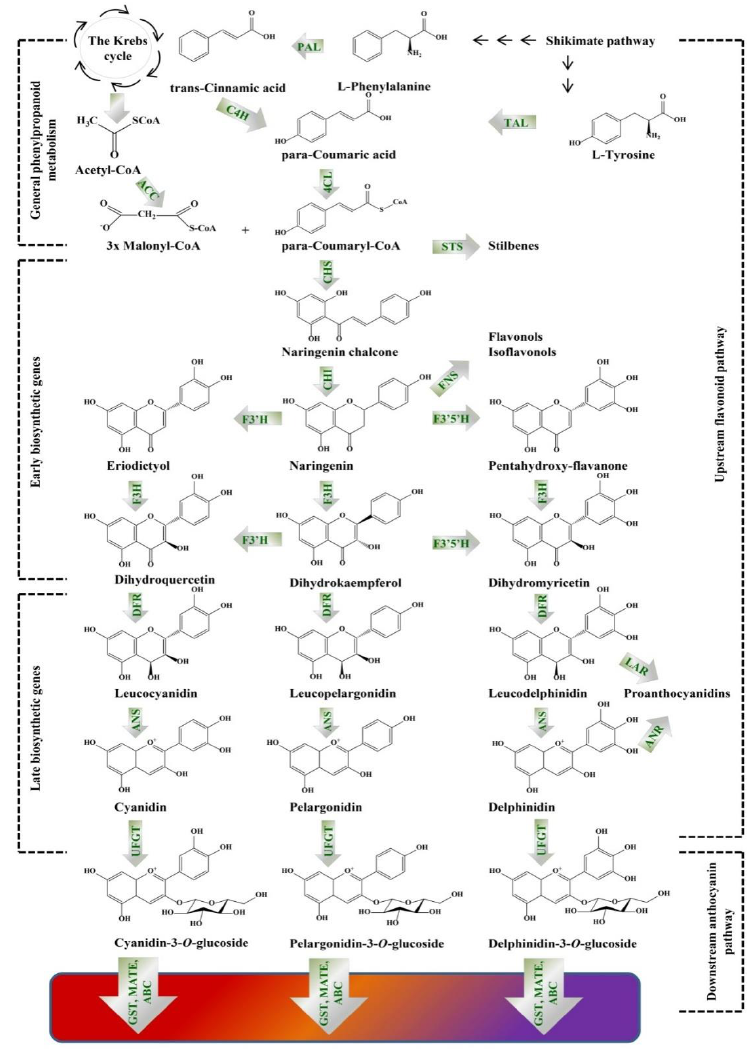
Figure 1. Illustration, presenting the biosynthetic pathway of colored anthocyanins. PAL, phenylalanine ammonia lyase (EC 4.3.1.24); TAL, tyrosine ammonia lyase (EC 4.3.1.23); C4H, cinnamate 4-hydroxylase (EC 1.14.14.91); ACC, acetyl-CoA carboxylase (EC 6.4.1.2); 4CL, 4- coumarate-CoA ligase (EC 6.2.1.12); CHS, chalcone synthase (EC 2.3.1.74); STS, stilbene synthase (EC 2.3.1.95); CHI, chalcone isomerase (EC 5.5.1.6); F3′H, flavonoid 3’-hydroxylase (EC 1.14.13.21); F3′5′H, flavonoid 3´5´-hydroxylase (EC 1.14.13.88); FNS, flavones synthase (EC 1.14.11.22); F3H, flavanone 3- hydroxylase (EC 1.14.11.9); DFR, dihydroflavonol 4-reductase (EC 1.1.1.219); ANS, anthocyanidin synthase (EC 1.14.20.4); LAR, leucoanthocyanidin reductase (EC 1.17.1.3); ANR, anthocyanidin reductase (EC 1.3.1.112); UFGT, UDP-glucose:flavonoid-3- O -glycosyltransferase (EC 2.4.1.115); GST, glutathione S -transferase (EC EC 2.5.1.18); MATE, multidrug and toxic compound extrusion transporter; ABC, ATP-binding cassette transporter. Phenylalanine is deaminated by PAL to